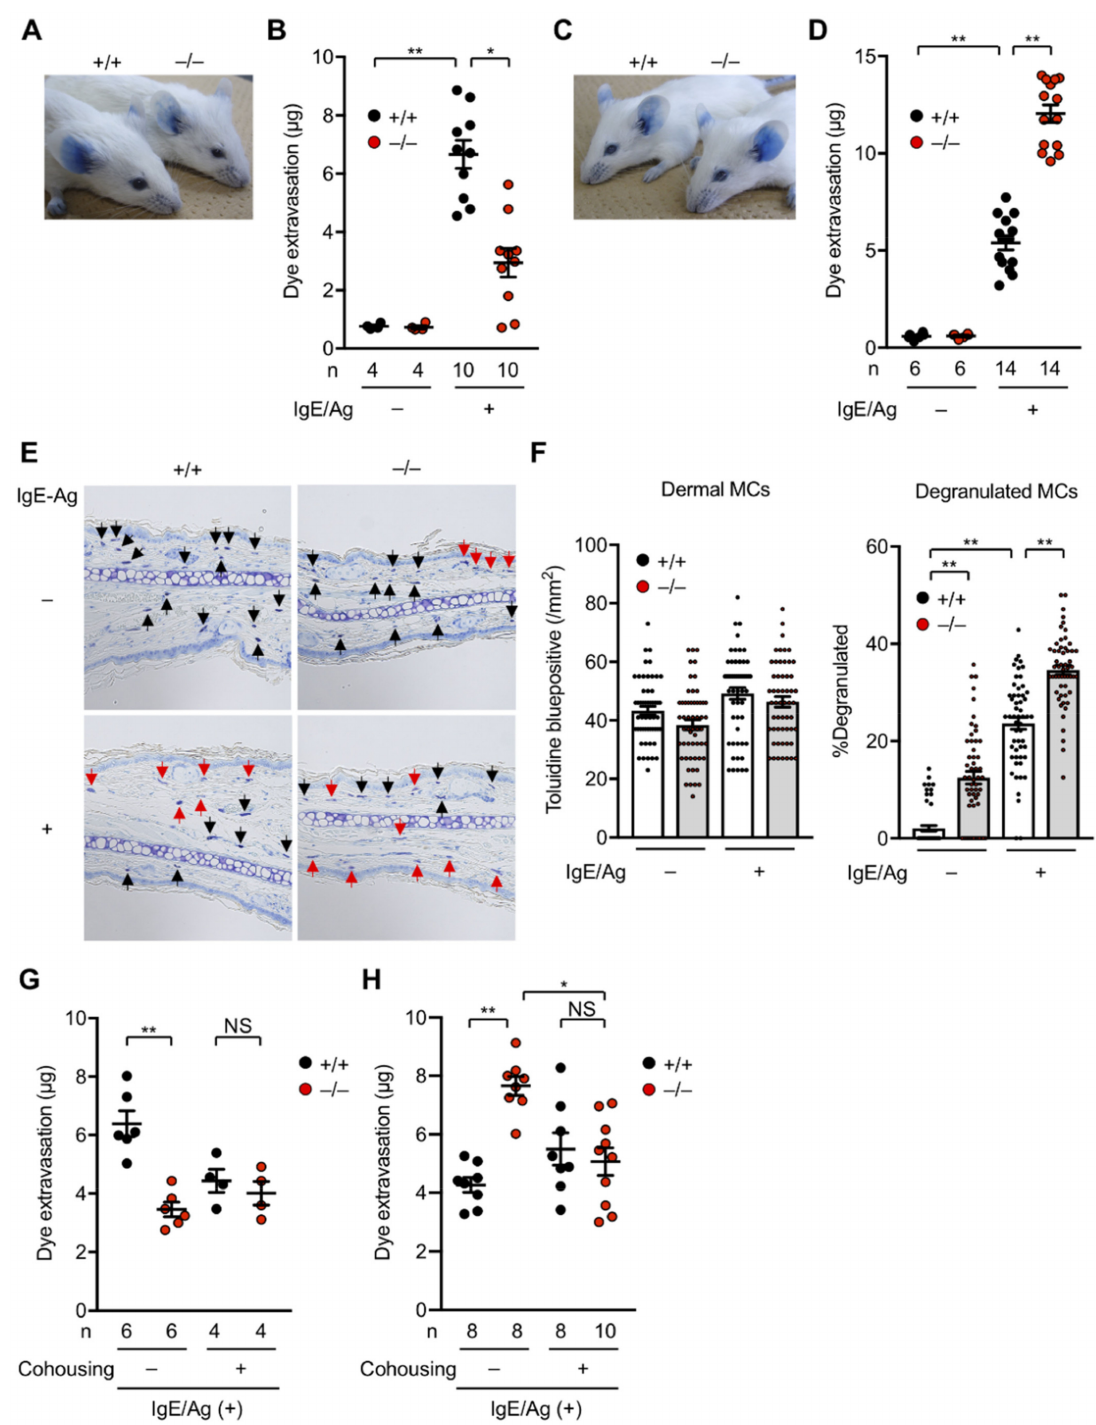
Figure 3. Altered PCA responses in Pla2g2a − / − BALB/c mice under distinct housing conditions. Ears of Pla2g2a +/+ and Pla2g2a − / − mice (8–12 weeks of age, male) were sensitized by subcutaneous injection of anti-DNP IgE monoclonal antibody (30 ng) and then challenged by intravenous injection of a mixture of DNP-conjugated human serum albumin (60 µ g) as an antigen (Ag) together with 1 mg Evans blue, as described previously [75]: ( A – D ) Representative photos of the ears ( A , C ) and quantification of dye extravasation ( B , D ) in IgE/Ag-treated (+) or -untreated ( − ) Pla2g2a +/+ and PLa2g2a − / − mice housed in the TMIMS ( A , B ) and UTokyo ( C , D ) facilities. ( E , F ) Histology of the skin ( E ) and quantification of total and degranulated mast cells ( F ) in IgE/Ag-treated or -untreated Pla2g2a +/+ and Pla2g2a − / − mice housed in the UTokyo facility. The ear pinnae were fixed with